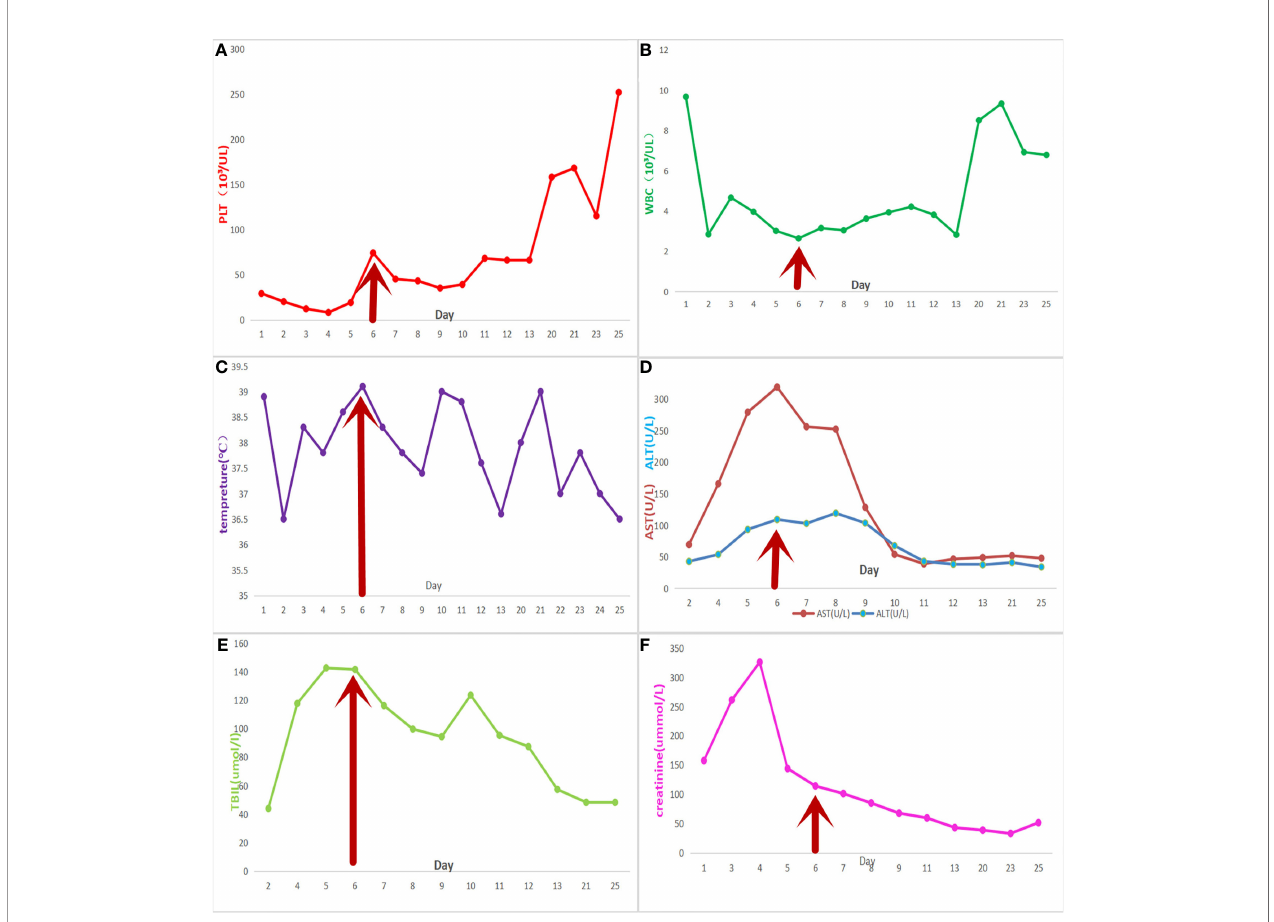
FIGURE 1 | Meropenem was used from the third day onwards. The red arrow represents the start time of the fi nal treatment plan. The patient was discharged on the 13th day and was hospitalized again on the 20th day. (A) platelet count; (B) white blood cell count; (C) daily maximum temperature; (D) liver function tests, aspartate transaminase, and alkaline phosphatase; (E) total bilirubin level; and (F) creatinine